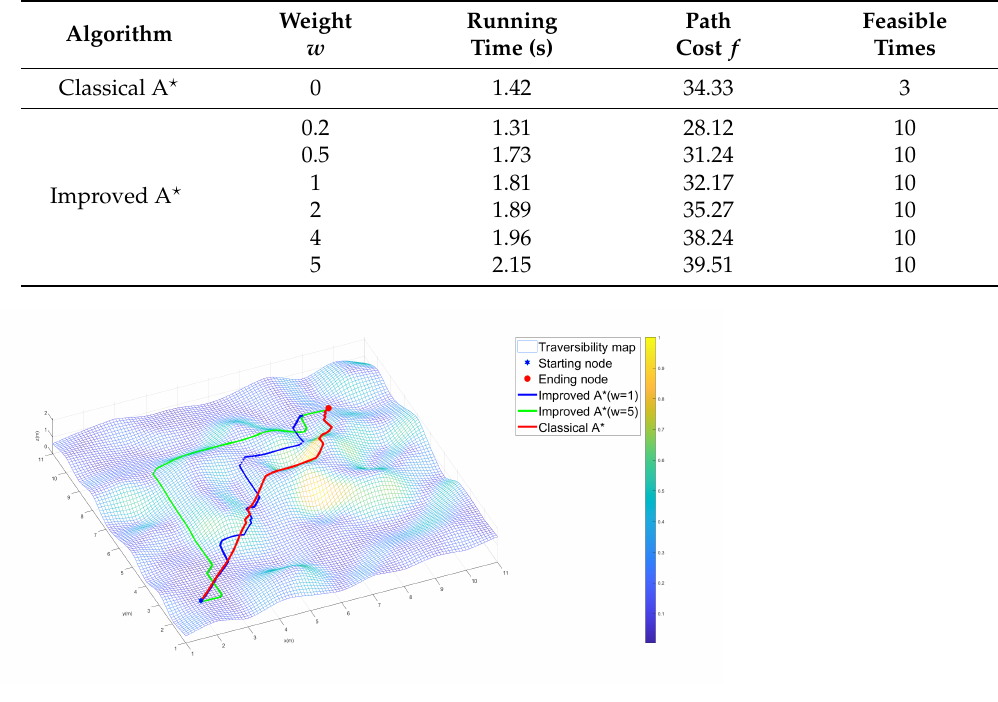
Figure 2. Global path planned by each algorithm in one